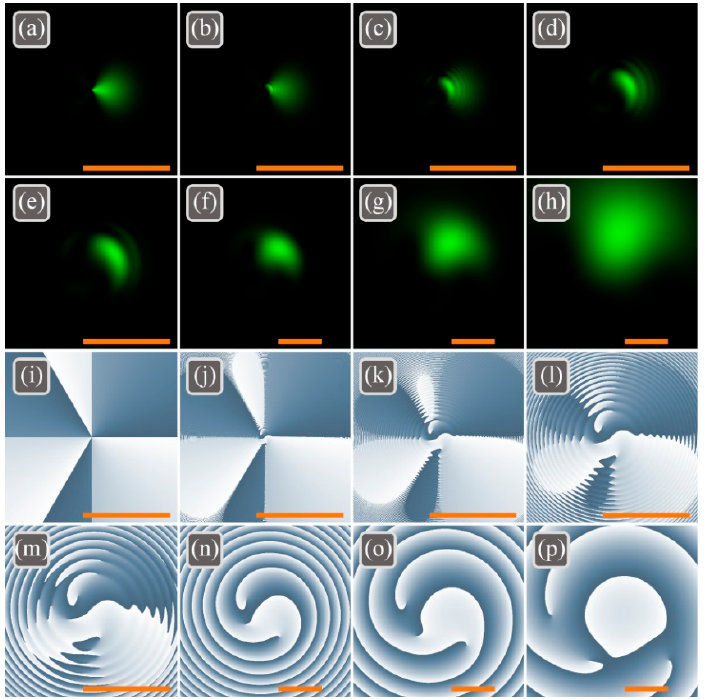
Figure 1. The intensity ( a – h ) and the phase ( i – p ) distributions of the light field (1) with n = 3, k = 0, m = 1, a = 1, w 0 = 500 μ m in the planes z = 0 ( a , i ), z = z 0 /200 ( b , j ), z = z 0 /50 ( c , k ), z = z 0 /20 ( d , l ), z = z 0 /10 ( e , m ), z = z 0 /2 ( f , n ), z = z 0 ( g , o ), z = 2 z 0 ( h , p ). The scale mark in each figure corresponds to 1 mm.